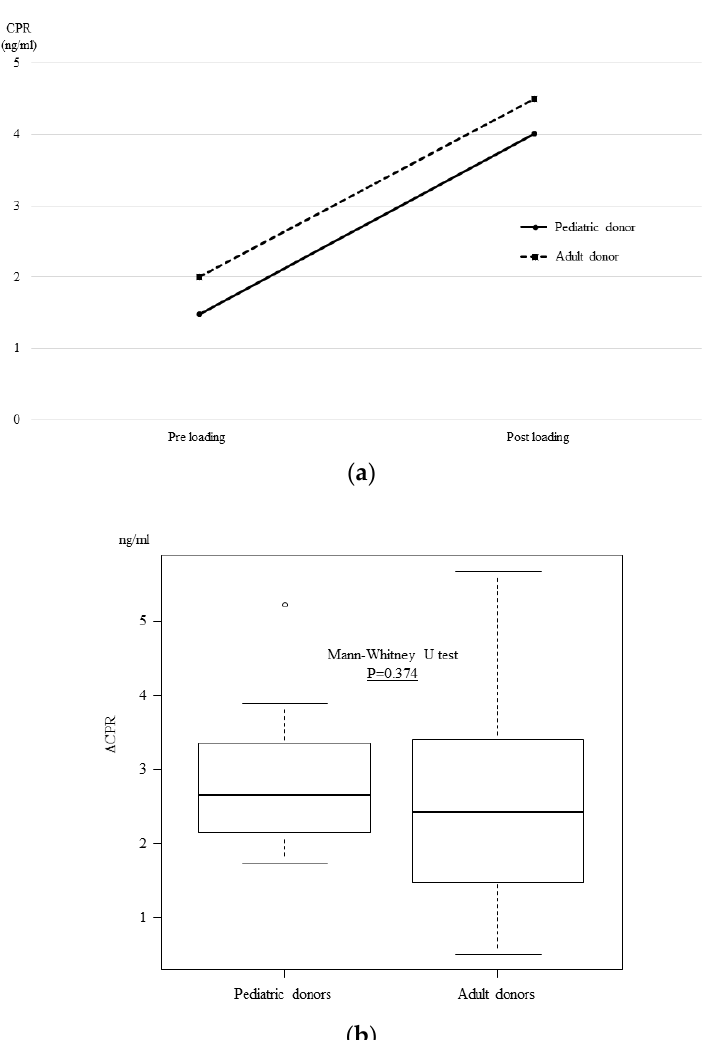
Figure 5. The glucagon stimulation test results at one month after transplantation. The glucagon stimulation test at one month post-transplantation showed that there was no significant difference between the two groups before or after glucagon loading ( a ) and the ΔCPR did not differ to a statistically significant extent ( b ).